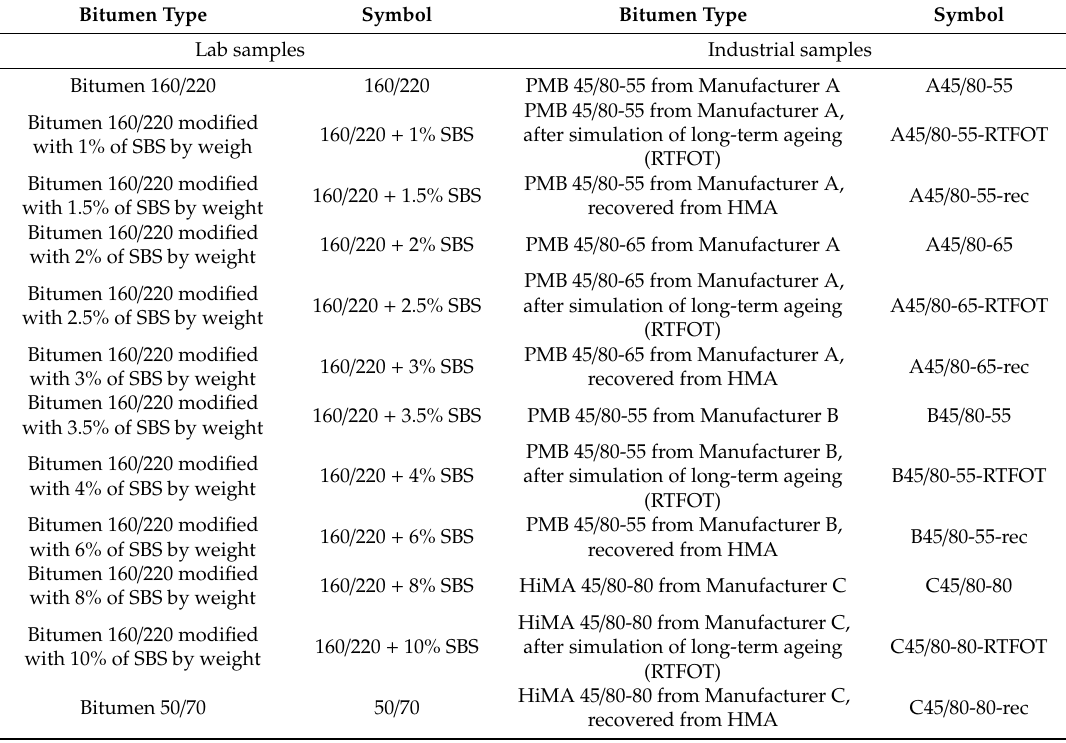
Table 3. List of samples prepared for the tests and their symbols.